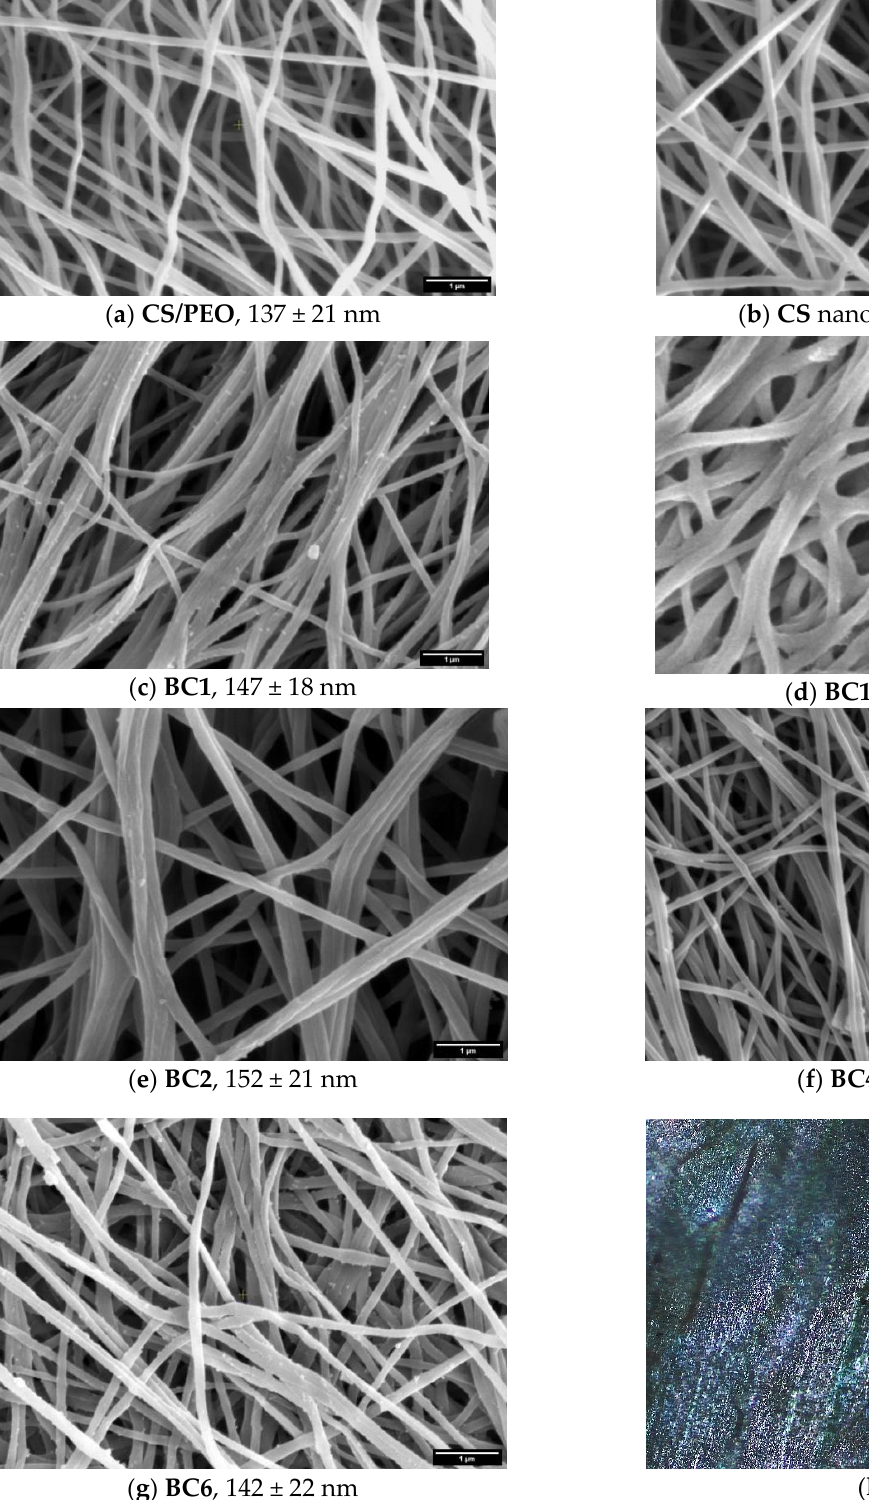
Figure 4. Representative ( a – g ) SEM images of the CS/PEO , CS , and imino-chitosan samples (scale: 1 μm ) and ( h ) POM image of BC1R sample ( scale: 100 μm ).